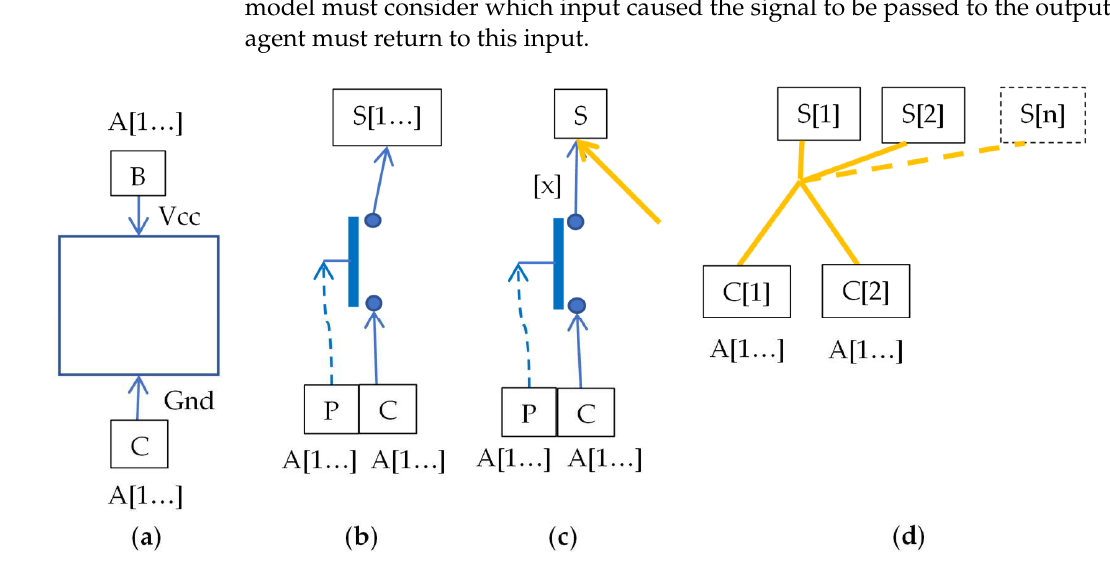
Figure 4. Connection diagrams of selected logical elements: ( a ) coil, ( b ) contact/switch being the only source of signal, but potentially for many elements at the output ( c ) contact/switch not being the only source of signal (with number x), for one element at the output ( d ) galvanic connection. A [1 . . . ] is a vector of all agents (any agent can give a signal). S [1 . . . ] is a vector of elements on